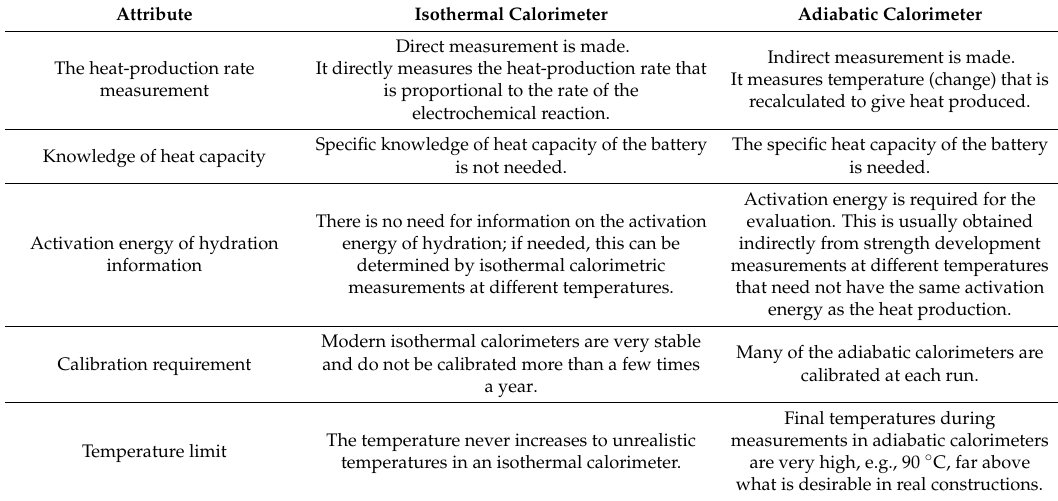
Table 6. Comparison between adiabatic and isothermal calorimeters